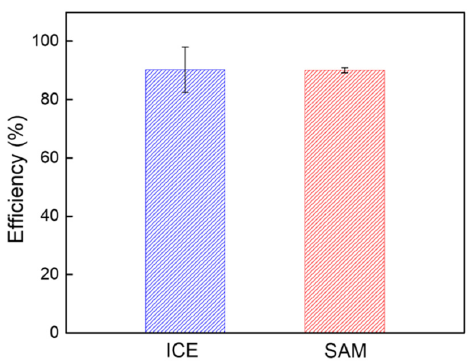
Figure 6. Efficiency percentage (%) for the re ‐ use ICE and the re ‐ deposition SAM. Columns and bars represent the averages and standard deviations of the data ( n = 3).